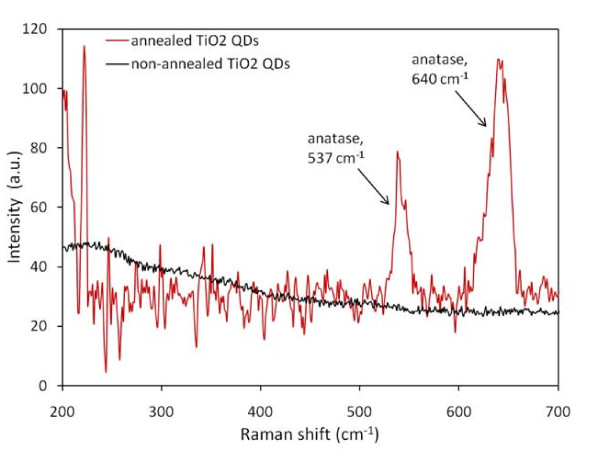
Raman spectra of annealed and non-annealed TiO2 QDs.